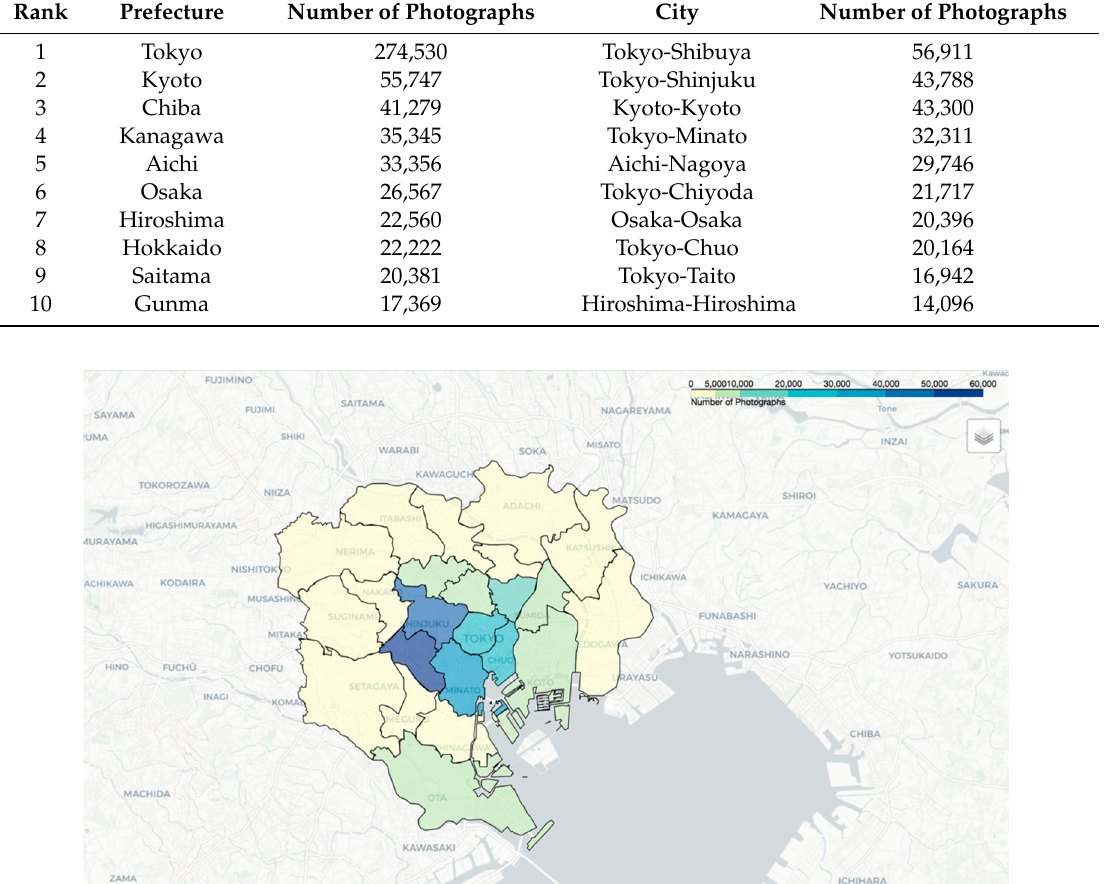
Figure 2. Distribution of photographs for Special ward of Tokyo.